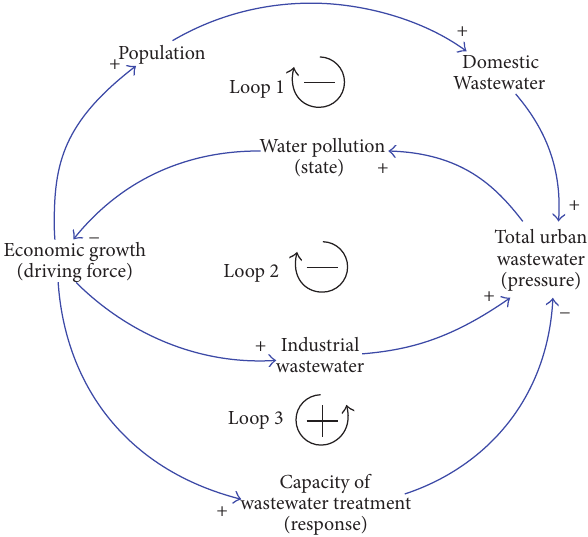
Figure 1: The causal loop diagram of the